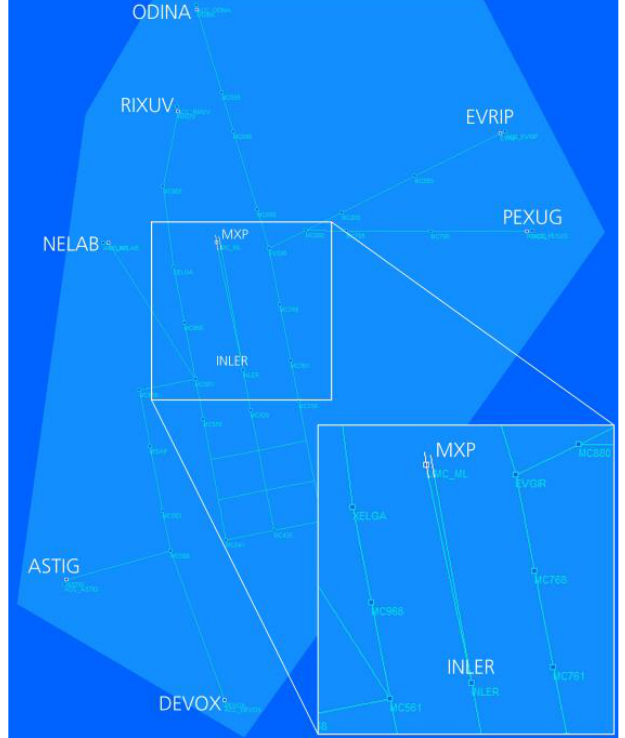
Figure 16. The Malpensa airport and airspace in the AMAN planning and simulation environment.